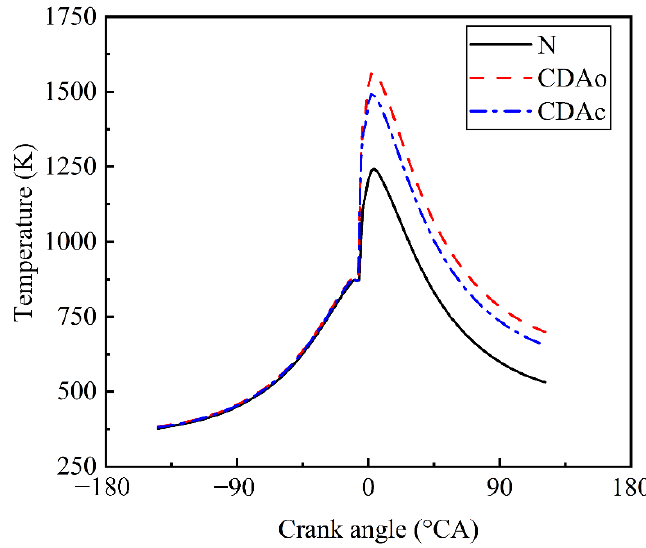
Figure 14. The change in gas temperature in the active cylinder with respect to crank angle for the normal operation and two CDA modes at an engine speed of 450 rpm and an engine load of 1000 N ∙ m (the calculated results were obtained from 3D simulation of ESE DIESEL).